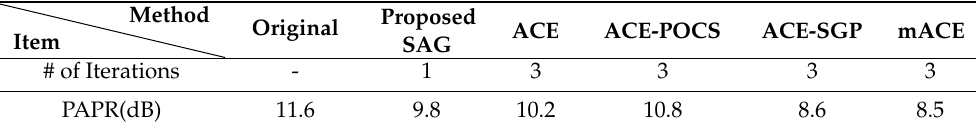
Table 3. PAPR performance comparison for 16QAM–OFDM with N = 256.